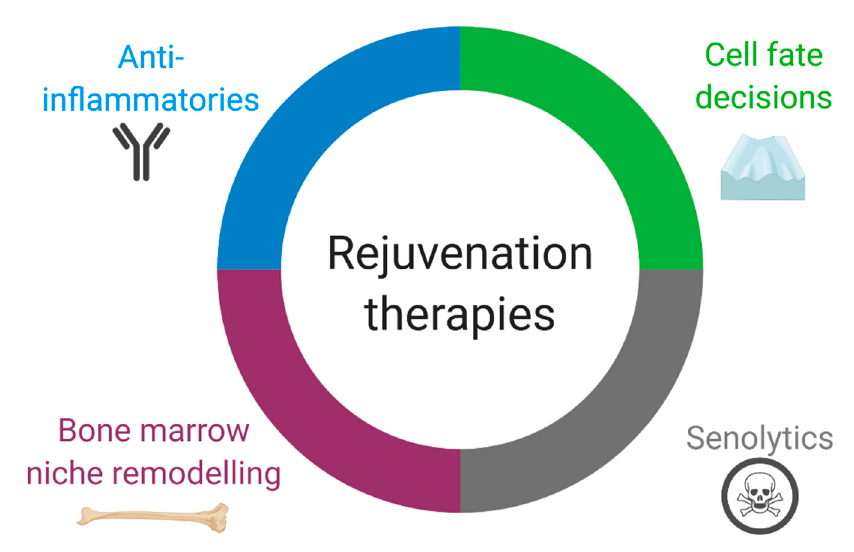
Figure 3. Putative rejuvenation therapies to reverse HSC and immune cell aging.